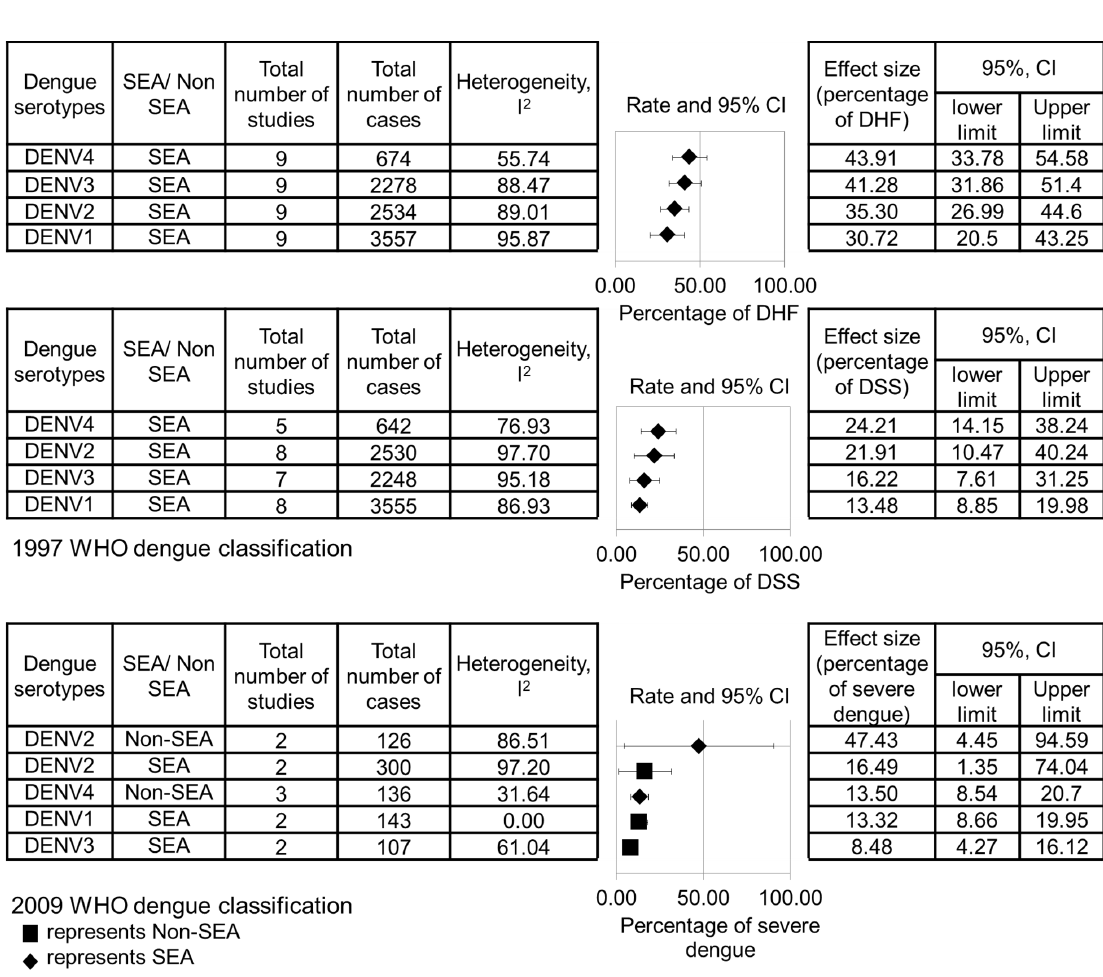
Fig 3. Pooled effect size of the relationship between dengue serotypes and percentage of DHF, DSS, as well as severe dengue infections. The data are arranged in a descending order based on the percentages of DHF, DSS and severe dengue infections. The data are separated by 1997 and 2009 WHO dengue classifications.